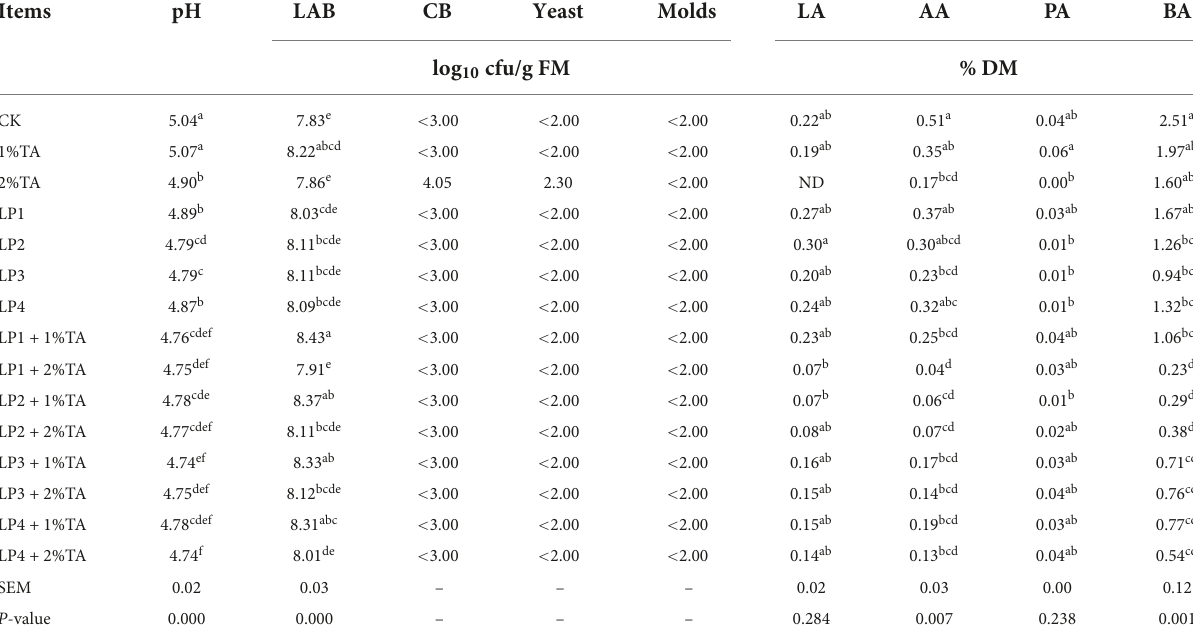
TABLE 2 Effects of the addition of lactic acid bacteria (LAB) and tannic acid on the fermentation parameters and microbial quantity of silage of Stylosanthes .